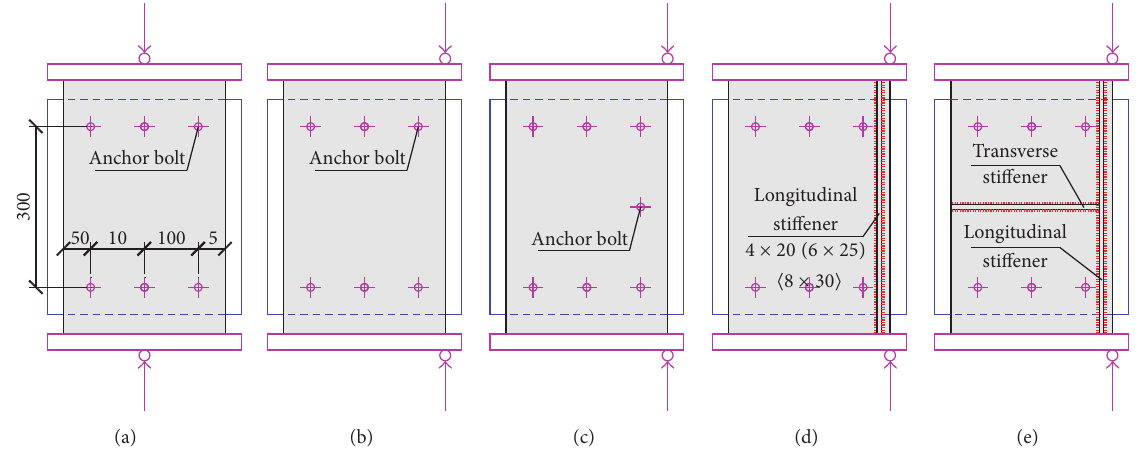
Figure 4: Restrain configuration of specimens (a) C4NN, (b) E4NN (E6NN), (c) E4AN, (d) E4SN (E4MN) ⟨ E 4 LN ⟩ , and (e) E4SS.